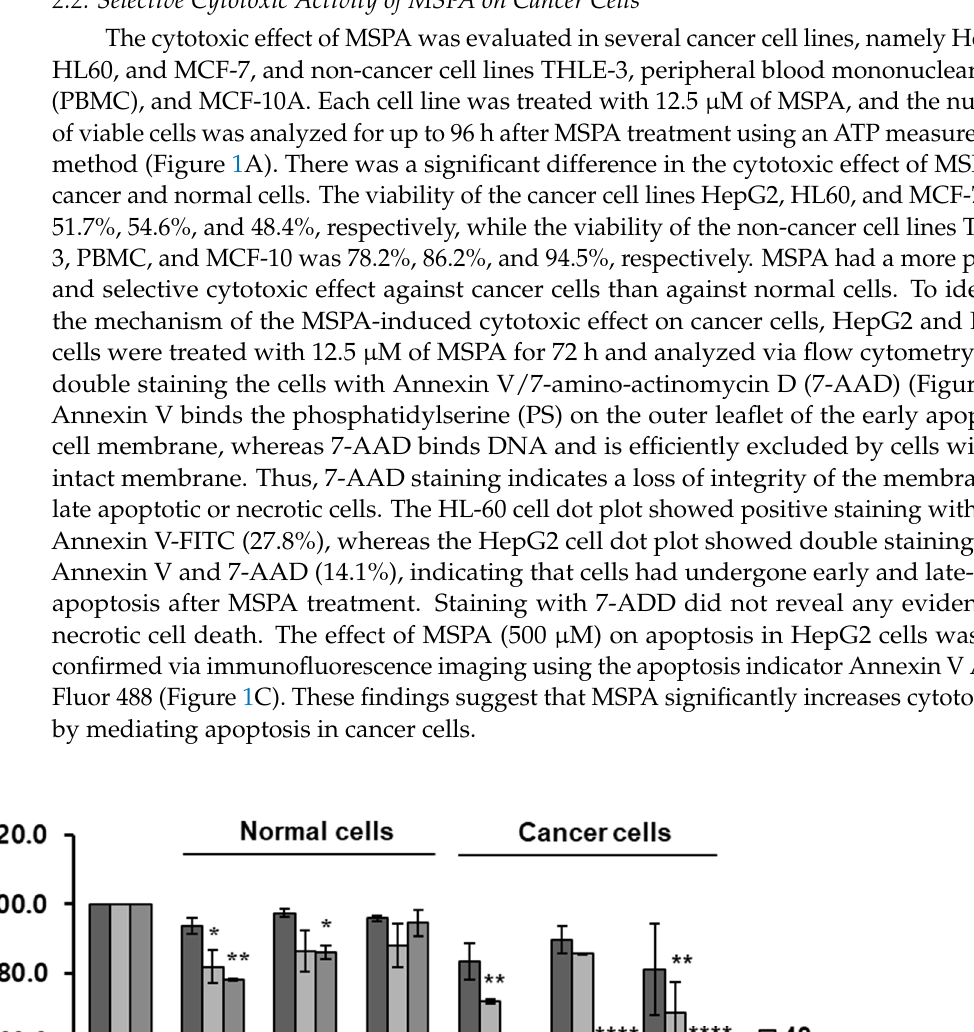
Figure 1. ( A ) The cytotoxic effects of macrosphelide A (MSPA) in cancer cell lines and non-cancer cell lines at 48 h, 72 h, and 96 h time points. The mock group represents vehicle-treated cell lines. Data represent the mean ± SD ( n = 3). * p < 0.05, ** p < 0.01**** p < 0.0001 versus vehicle-treated group (mock). ( B ) Apoptosis was determined using annexin V/7- aminoactinomycin D (7-ADD) staining in HepG2 and HL60 cell lines. Combined annexin V and 7-AAD reactivity allowed cells to be classified into four groups: early apoptotic cells (annexin V (+) and 7-AAD (−)), late apoptotic or dead cells (annexin V (+) and 7-AAD (+)), dead cells (annexin V (−) and 7-AAD (+)), and live cells (annexin V (−) and 7-AAD (−)). Data represent the mean ± SD ( n = 3). * p < 0.05, versus vehicle-treated cells. ( C ) HepG2 cells were treated with 500 μM of MSPA for 72 h and stained with annexin V Alexa Fluor 488 (green fluorescence). Cell nuclei are stained blue (Hoechst stain). Data represent the mean ± SD ( n = 3). *** p < 0.001 versus control (mock).